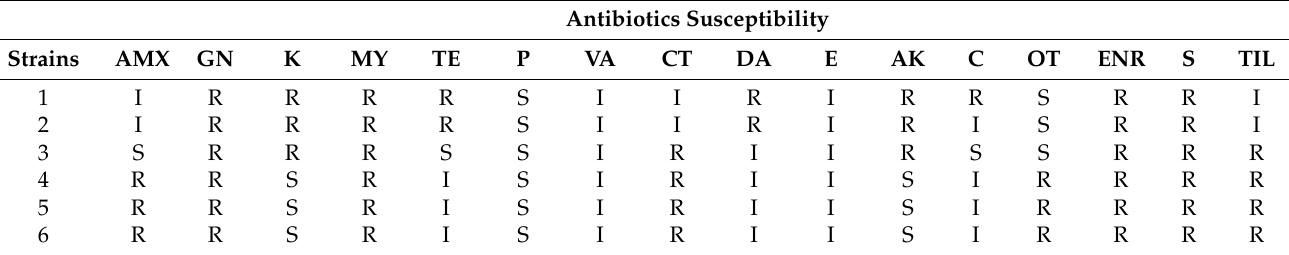
Table 5. Antibiotic susceptibility profile of LAB